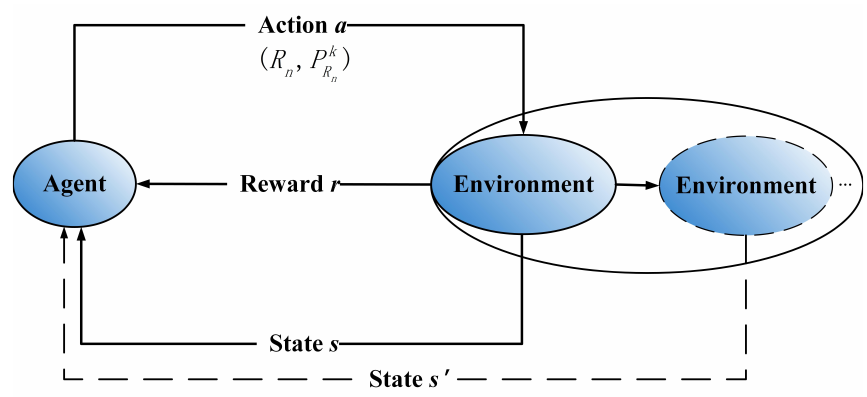
Figure 2. Framework of reinforcement